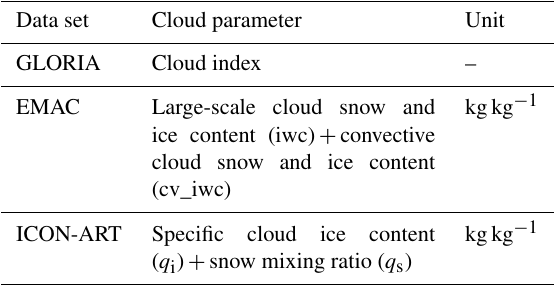
Table 1. Data sets and cloud parameters (cirrus and ice clouds).